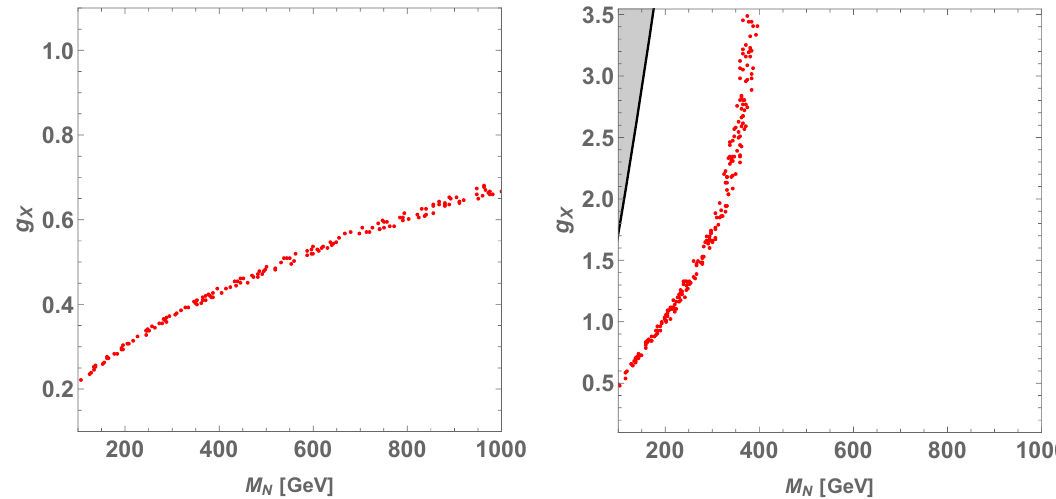
Figure 10 . Scatter plots of the parameter region in the m N - g X plane that satisfies 0 . 11 < Ω h 2 < 0 . 13 , considering only the Z 0 interactions. The left and the right plots correspond to cases of m N = 2 m Z 0 and m Z 0 = 2 . 025 m N , respectively. The gray region is excluded by XENON1T.